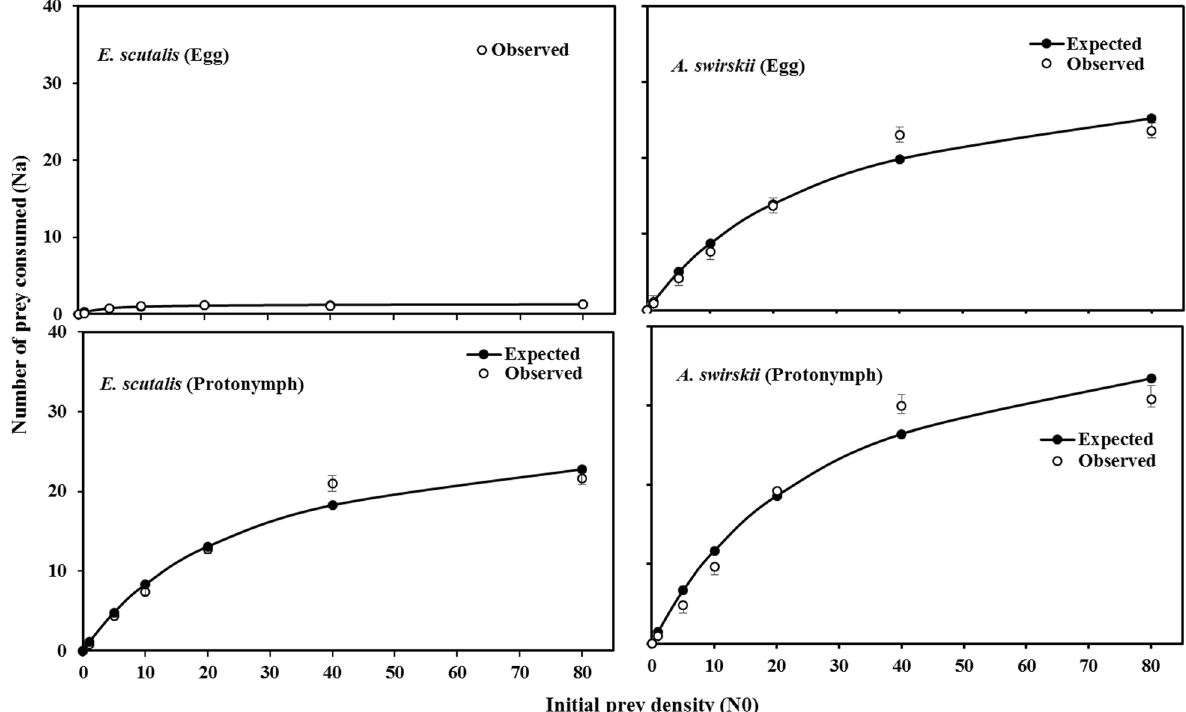
Fig. 1 Functional response curves of Amblyseius swirskii and Euseius scutalis to different egg, and protonymph densities of Eutetranychus orientalis (filled and nonfilled circles indicate expected and observed predation rates, respectively)